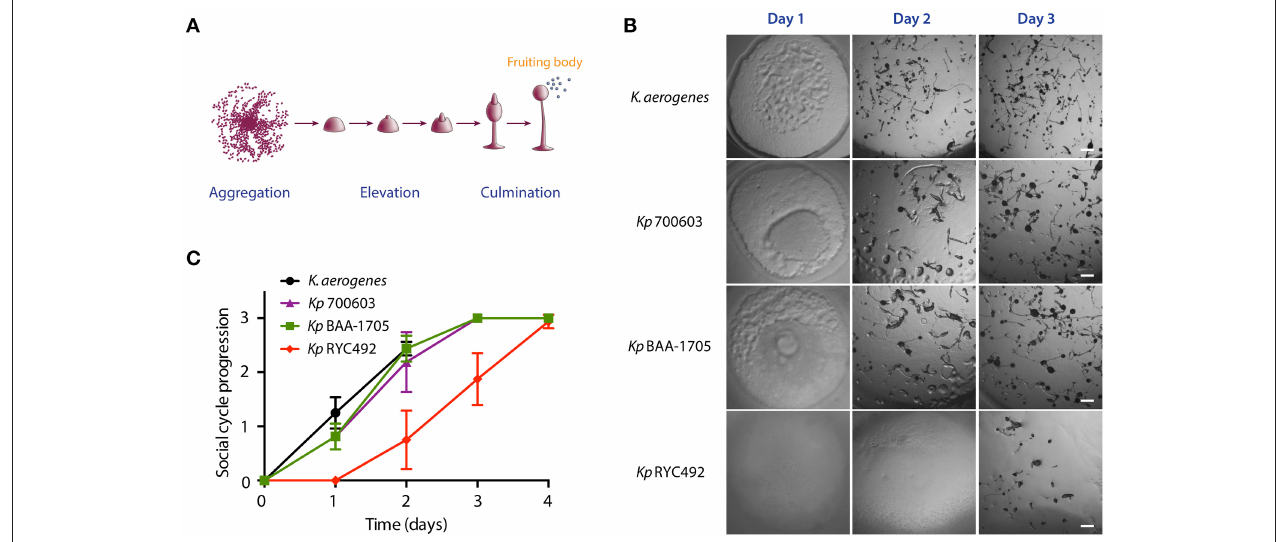
FIGURE 1 | Use of the D. discoideum social development assay to evaluate K. pneumoniae virulence. (A) Main stages of the D. discoideum social cycle, which culminates with the formation of the fruiting bodies. The scheme was adapted from Fey et al. (2007). (B) Micrographs of the social cycle progression when feeding amoeba with different K. pneumoniae strains or with K. aerogenes DBS0305928 (control). Scale bar, 100 µ m. (C) Semi-quantitative assessment of the social cycle progression in presence of different Klebsiella strains using several replicates. The symbols represent the mean of six independent experiments and the error bars show the standard deviation. The details on scoring criteria can be found in the Materials and Methods